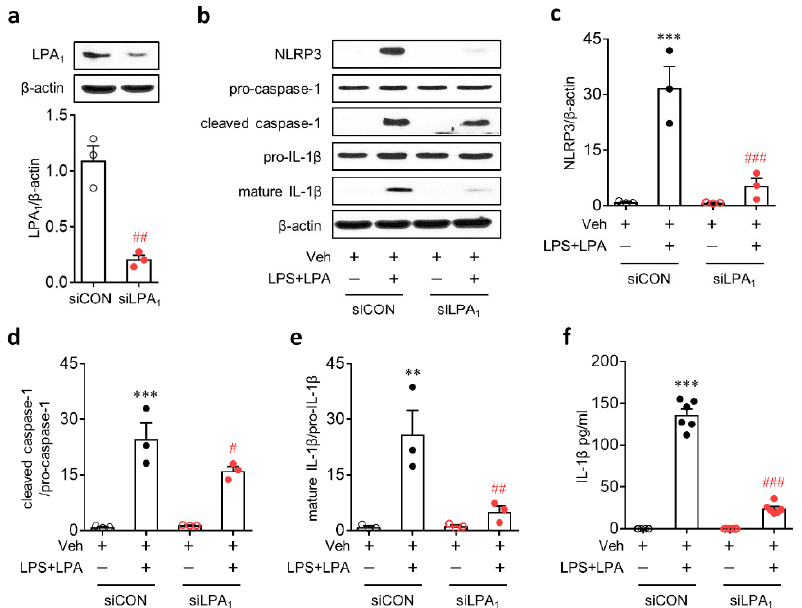
Figure 6. LPA 1 knockdown attenuates LPA-induced NLRP3 inflammasome activation in LPS-primed BMDMs . Transfected BMDMs with non-target control small interfering RNA (siRNA) (siCON)